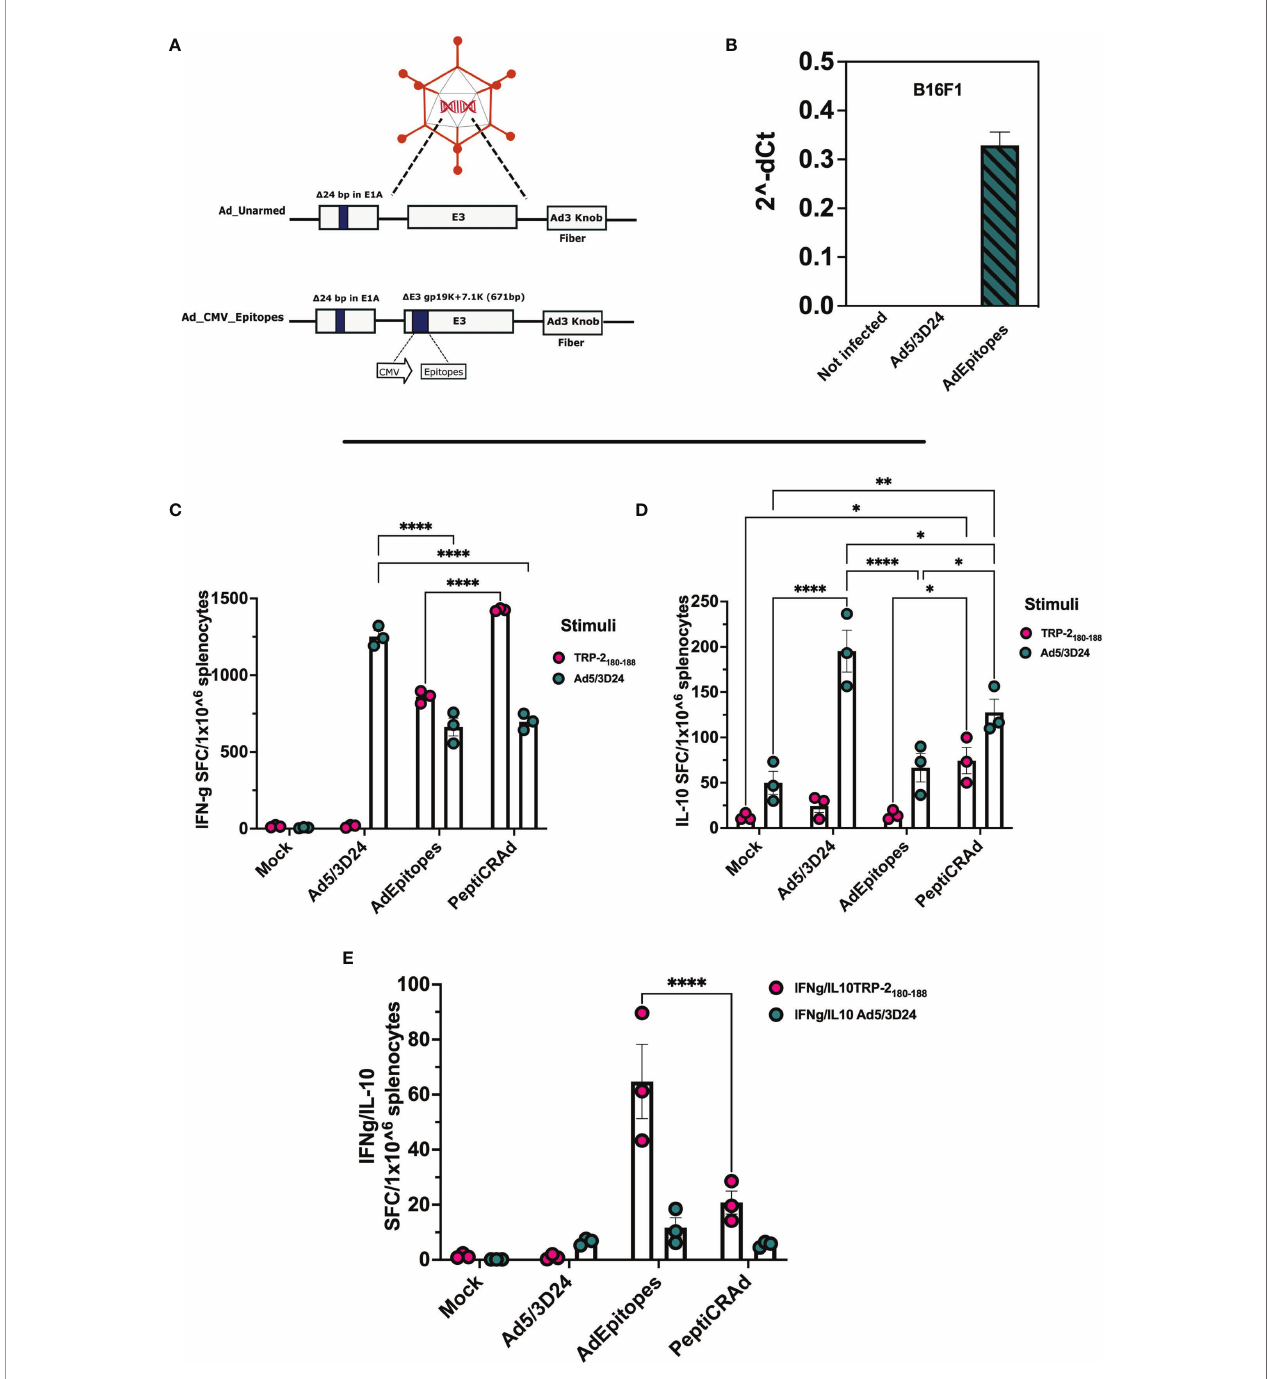
FIGURE 5 | Generation and characterization of AdEpitopes (A) Schematic representation of oncolytic adenovirus delta 24 (Ad5/3-D24) constructs with modi fi cations in E1, E3, and fi ber region. Both unarmed (Ad_unarmed) and armed (Ad_CMV_Epitopes) bear a deletion of 24bp in the E1A gene. Additionally, AdEpitopes (Ad_CMV_Epitopes) contains an expression cassette under CMV promoter in E3 region. (B) Real-time PCR was performed in B16F1 infected with 5MOI of AdEpitopes, Ad5/3 D 24 or left untreated (not infected) and the fold gene expression is analyzed as 2 -dCt .The data are represented ad bar blot and mean ± SEM. (C) IFN- g ELISpot was performed on harvested splenocytes from mice treated with Ad5/3 D 24, AdEpitopes or PBS (Mock). The individual response to TRP2 (pink) and Ad5/3 D 24 (green) is reported as IFN - g spot forming cells (SFC)/10 6 splenocytes. (D) IL-10 FluoroSpot evaluated the level of IL-10 released upon stimulation with TRP2 (pink) and Ad5/3 D 24 (green) in splenocytes harvested from mice immunized with Ad5/3 D 24, AdEpitopes or PBS (Mock). (E) The ratio IFN - g /IL-10 spot forming cells is depicted and TRP2 (pink) and Ad5/3 D 24 (green). The data are shown as bar and dot plot for each technical replicate, and mean ± SEM. Signi fi cance was assessed with ordinary One-way ANOVA (ns P > 0.05, *P ≤ 0.05, **P ≤ 0.01, ***P ≤ 0.001, ****P ≤